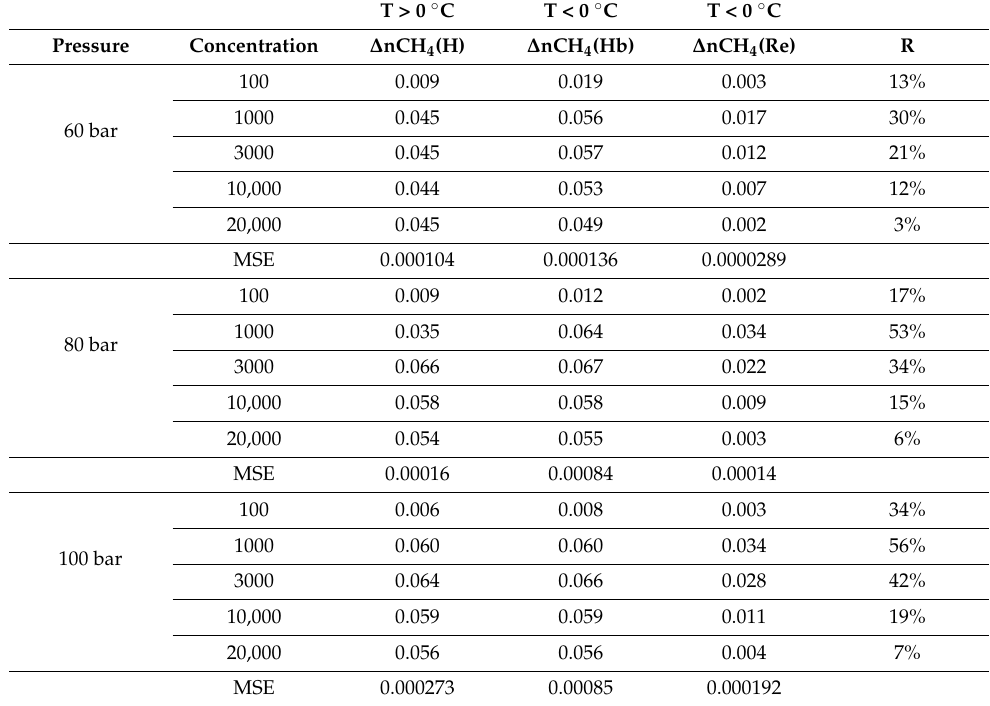
Table A9. Total mole CH 4 released in the presence of methionine at T = − 2 ◦ C. ∆ nCH 4 (Hb) is the moles of CH 4 stored in hydrate at T = − 2 ◦ C. ∆ nCH 4 (R) is moles of CH 4 release. Thus, R is the ratio of mole released/mole stored in hydrate in 24 h. (Second run).